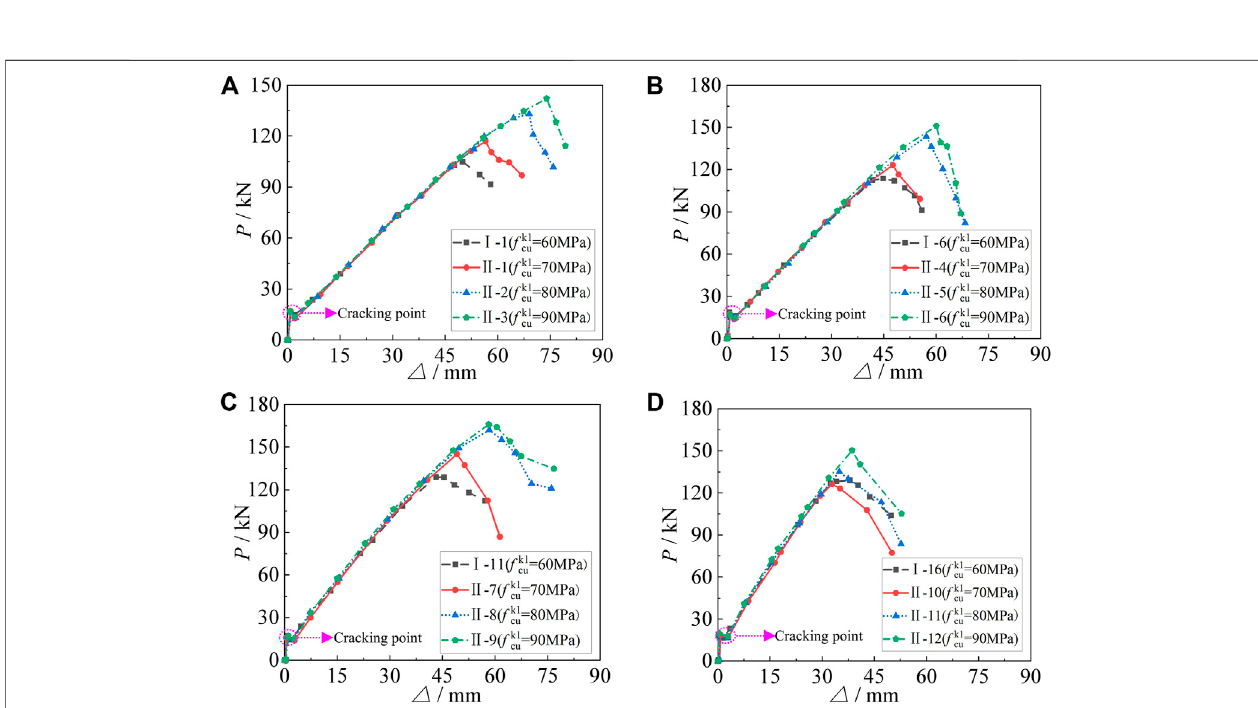
FIGURE10| Comparisonofload – displacementcurvesofsimplysupportedbeamswithdifferent ρ GFRP : (A) h 1 (cid:2) 30 mm; (B) h 2 (cid:2) 60 mm; (C) h 3 (cid:2) 90 mm; (D) h4 (cid:2) 120 mm.